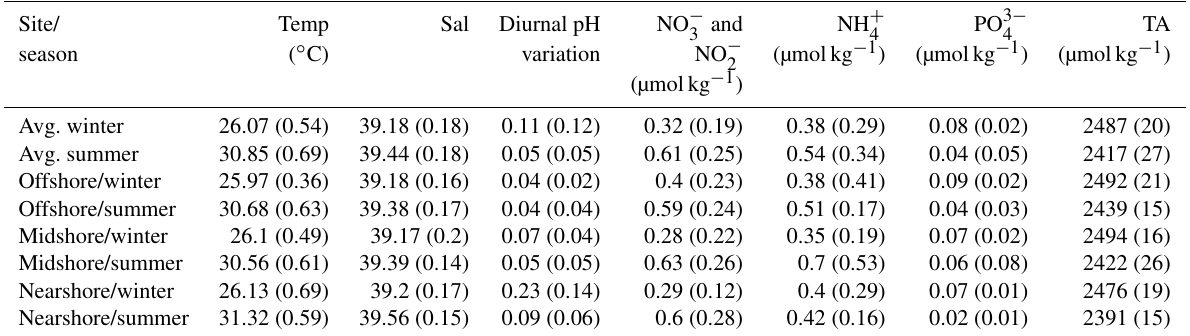
Table 4. Abiotic parameters relevant for reef growth at the study sites along a cross-shelf gradient in the central Red Sea. Temperature (Temp), salinity (Sal), and diurnal pH variation (diurnal SDs of pH NBS measurements) were continuously measured using in situ probes (CTDs). Weekly collected seawater samples were used for the determination of inorganic nutrient concentrations, i.e., nitrate and